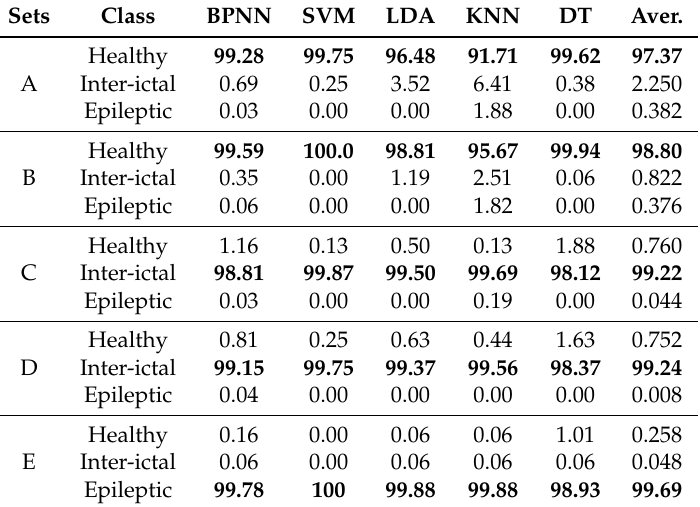
Table 5. Classification results of the five classifiers on all five data-sets of Case 3 (Back-Propagation Neural Network (BPNN), Support Vector Machine (SVM), Linear Discriminant Analysis (LDA), K-nearest neighbour (KNN), Decision Tree (DT), average value (Aver.)).